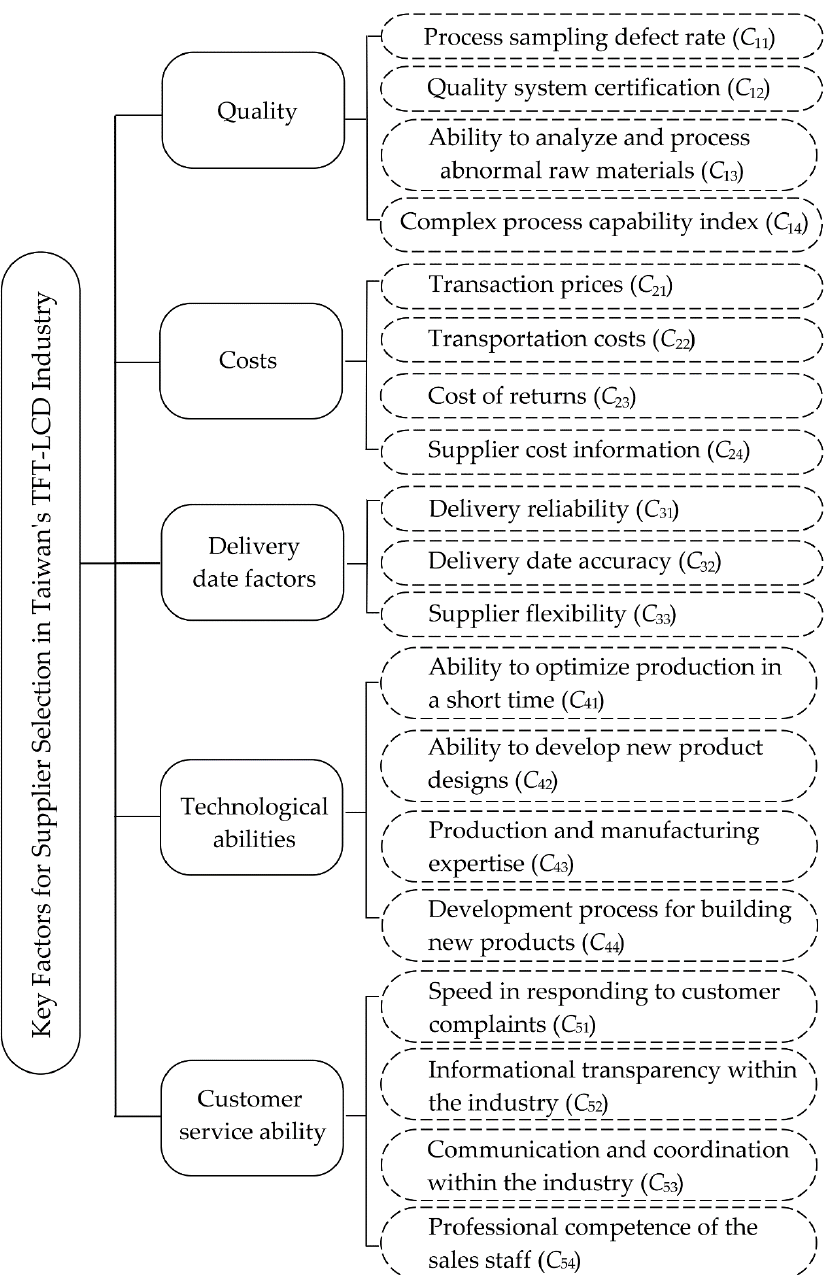
Figure 2. The prototype framework for supplier selection.